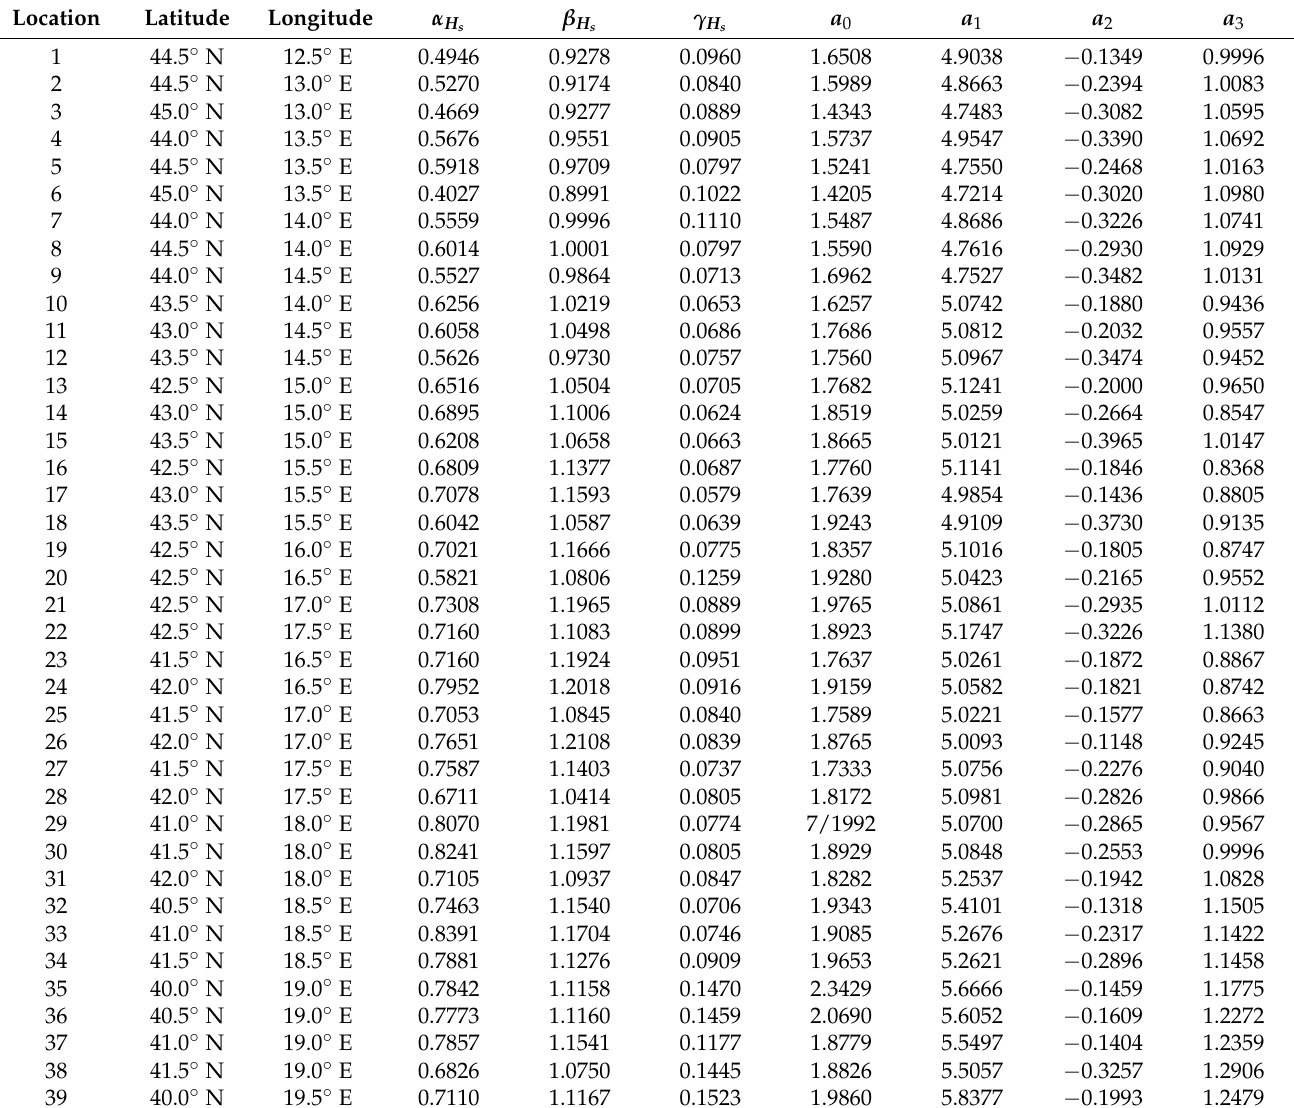
Table A10. Model parameters for joint distribution of Hs and Tp per location.